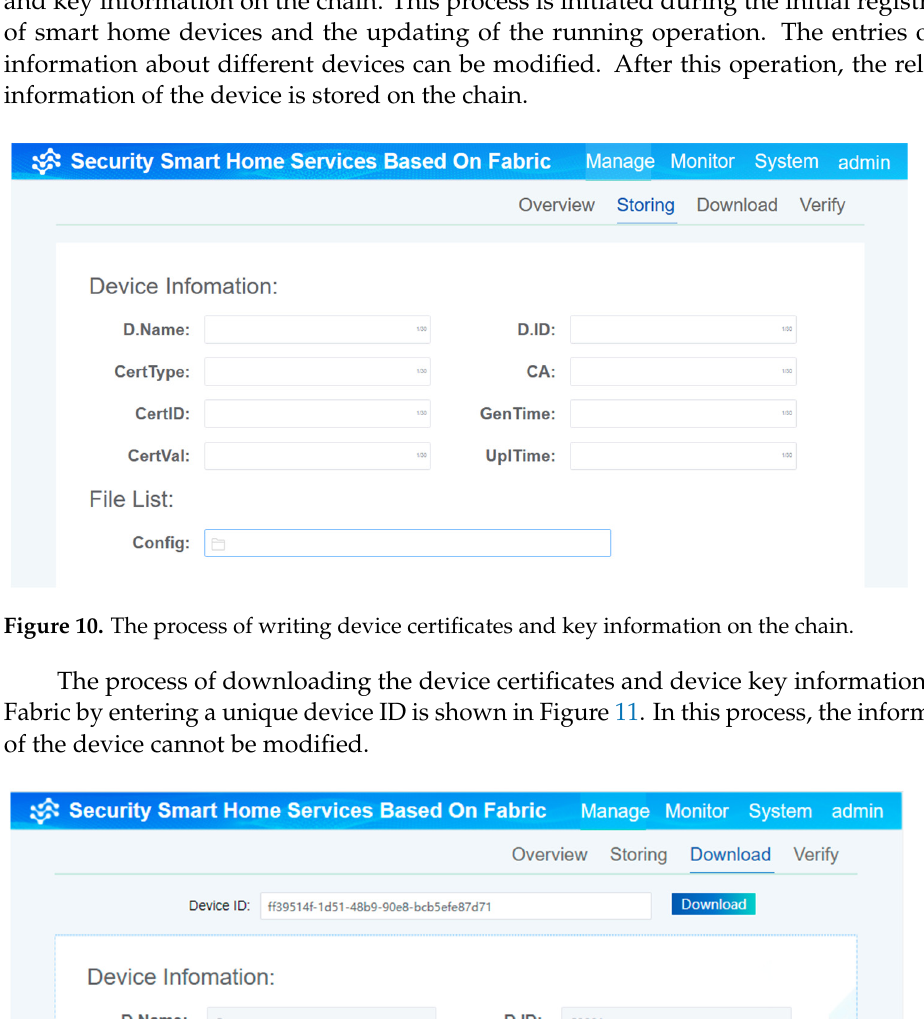
Figure 11. The process of downloading certificates and key information from the chain.